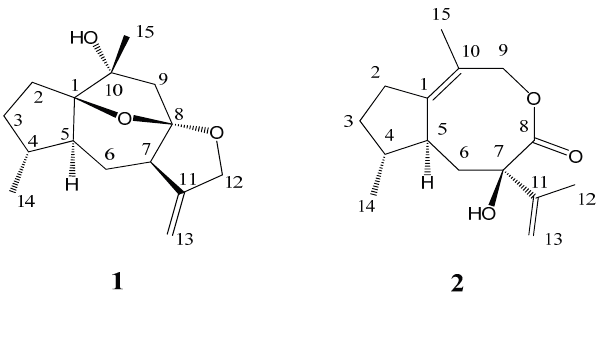
Figure 1. Structures of compounds 1 – 2